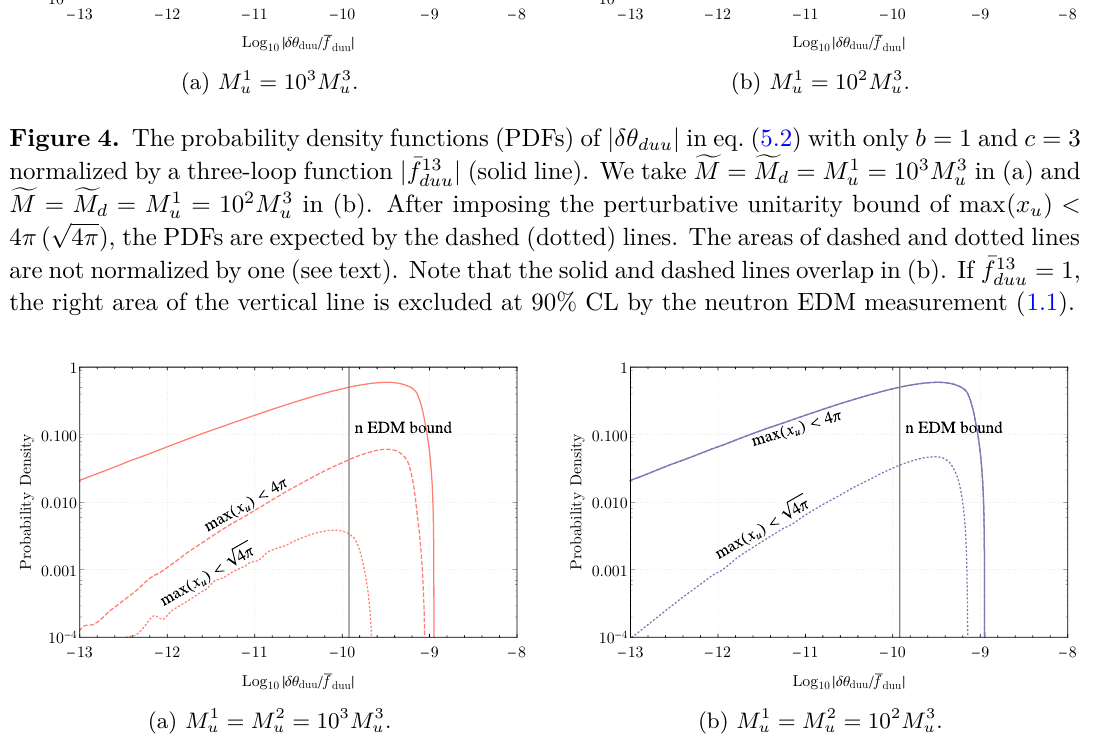
| = | ¯ f 23 | duu duu √ 4 π ) , the PDFs are